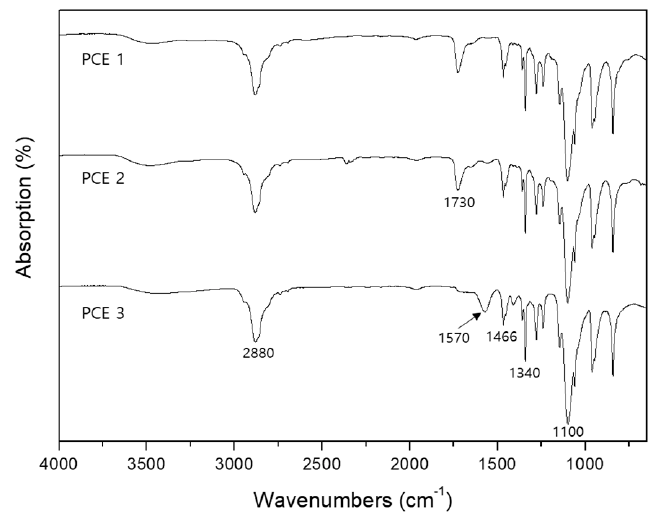
Figure3. FT-IRspectraofthepolycarboxylatesuperplasticizersusedinthisstudy. SuperplasticizersPCE Figure 3. FT-IR spectra of the polycarboxylate superplasticizers used in this study. Superplasticizers 1 and PCE 2 contain ester side chains, while PCE 3 includes ether side PCE 1 and PCE 2 contain ester side chains, while PCE 3 includes ether side chains.